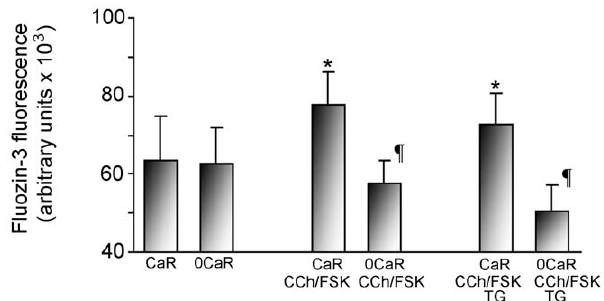
Figure 7. Rapid throughput assay showing influence of Ca 2 + availability on uptake of Zn 2 + in populations of isolated gastric glands, during exposure to secretagogues. Aliquots of fluozin-3 loaded glands (n=8 each group) were incubated in wells for 45 min in Ca-Ringer’s or 0Ca-Ringer’s solutions under control condi- tions, during exposure to secretagogue combination (carbachol CCh 100 m M, forskolin FSK, 10 m M), or during exposure to secretagogue combination and thapsigargin TG, 10 m M. Glands were then exposed for 10 min to solutions containing Zn 2 + 10 m M to monitor content. Results reported in total fluorescence units, means 6 SEM, *p , 0.05 compared to Ringer control, " p , 0.05 compared to CaR conditions. Designations: a) Ca-Ringer’s 45 min then Ringer’s/Zn 2 + 10 m M 15 min ( CaR ); b) 0Ca-Ringers 45 min/Zn 2 + 10 m M 15 min ( 0CaR ); c) Ca-Ringer’s, carbachol 100 m M, forskolin 10 m M for 45 min then Ca-Ringer’s, carbachol 100 m M, forskolin 10 m M, Zn 2 + 10 m M 15 min ( CaR-CCh- FSK ); d) 0Ca-Ringer’s/2 m M Thapsigargin 45 min then